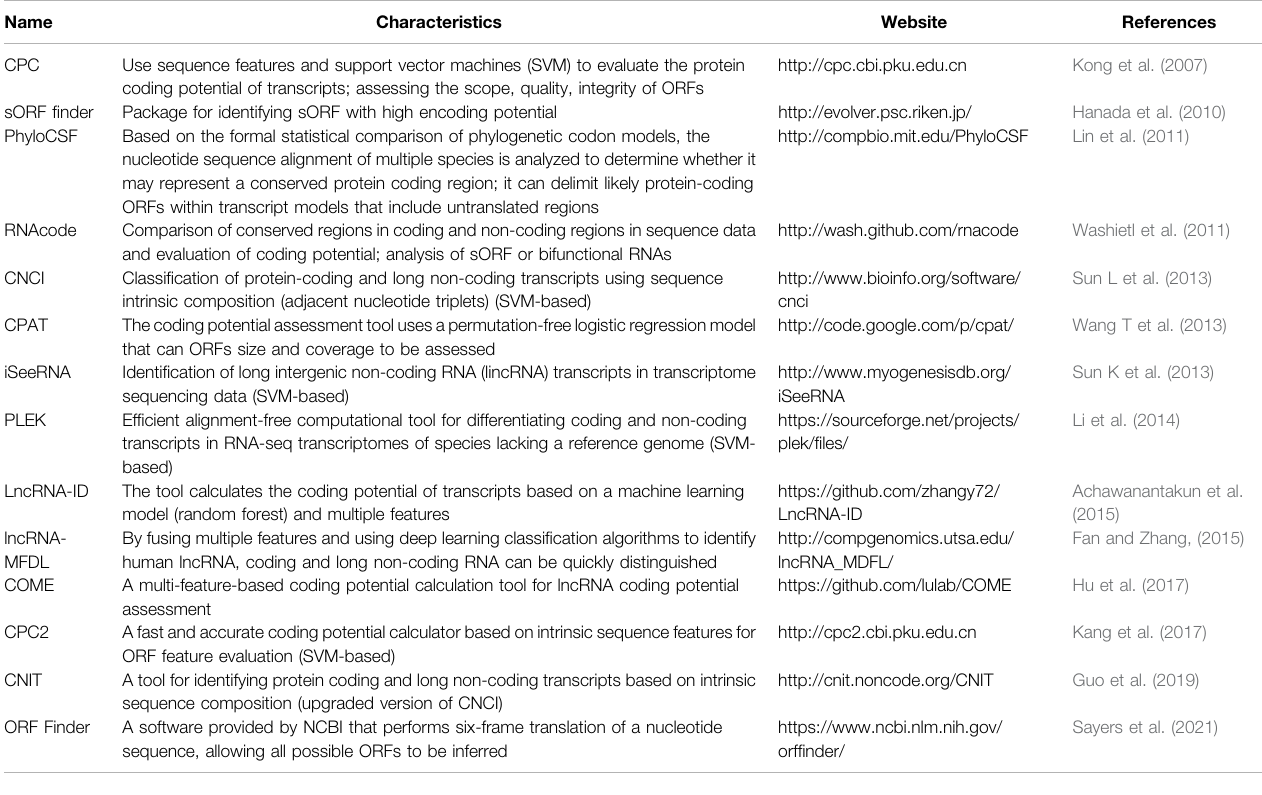
TABLE 2 | ORF prediction and evaluation related calculation tools.